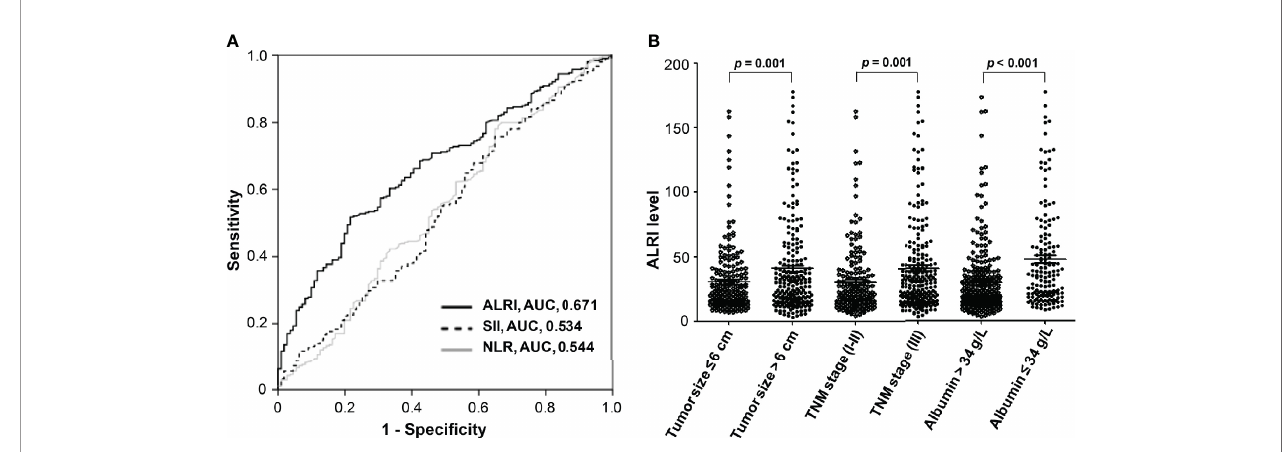
FIGURE 2 | Prognostic prediction value of ALRI for post-operative HCC patients in the training cohort and the comparison of ALRI level in different sub-groups. (A) Comparison of prediction performance of ALRI, SII, and NLR using the ROC analyses. (B) Comparison of ALRI level in different tumor size, TNM stage, and serum albumin